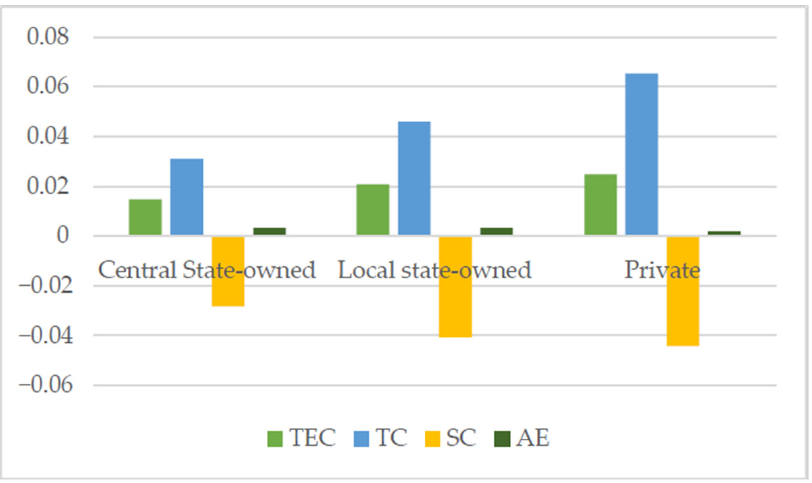
Figure 3. TFP decomposition by ownership enterprises.